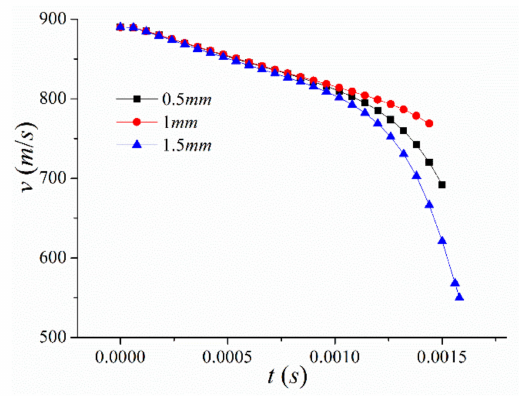
Figure 21. Velocity attenuation with di ff erent α .